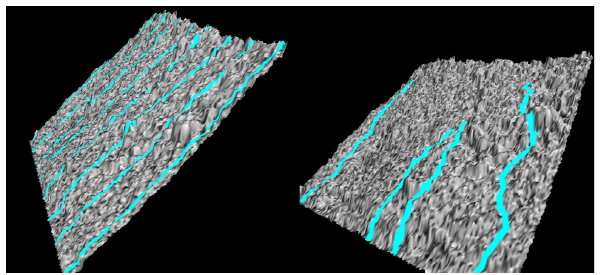
Figure 4. Profile lines across the DEM. Straight lines (left) and channel flow (right) are chosen dependent on the prevalent runoff type.